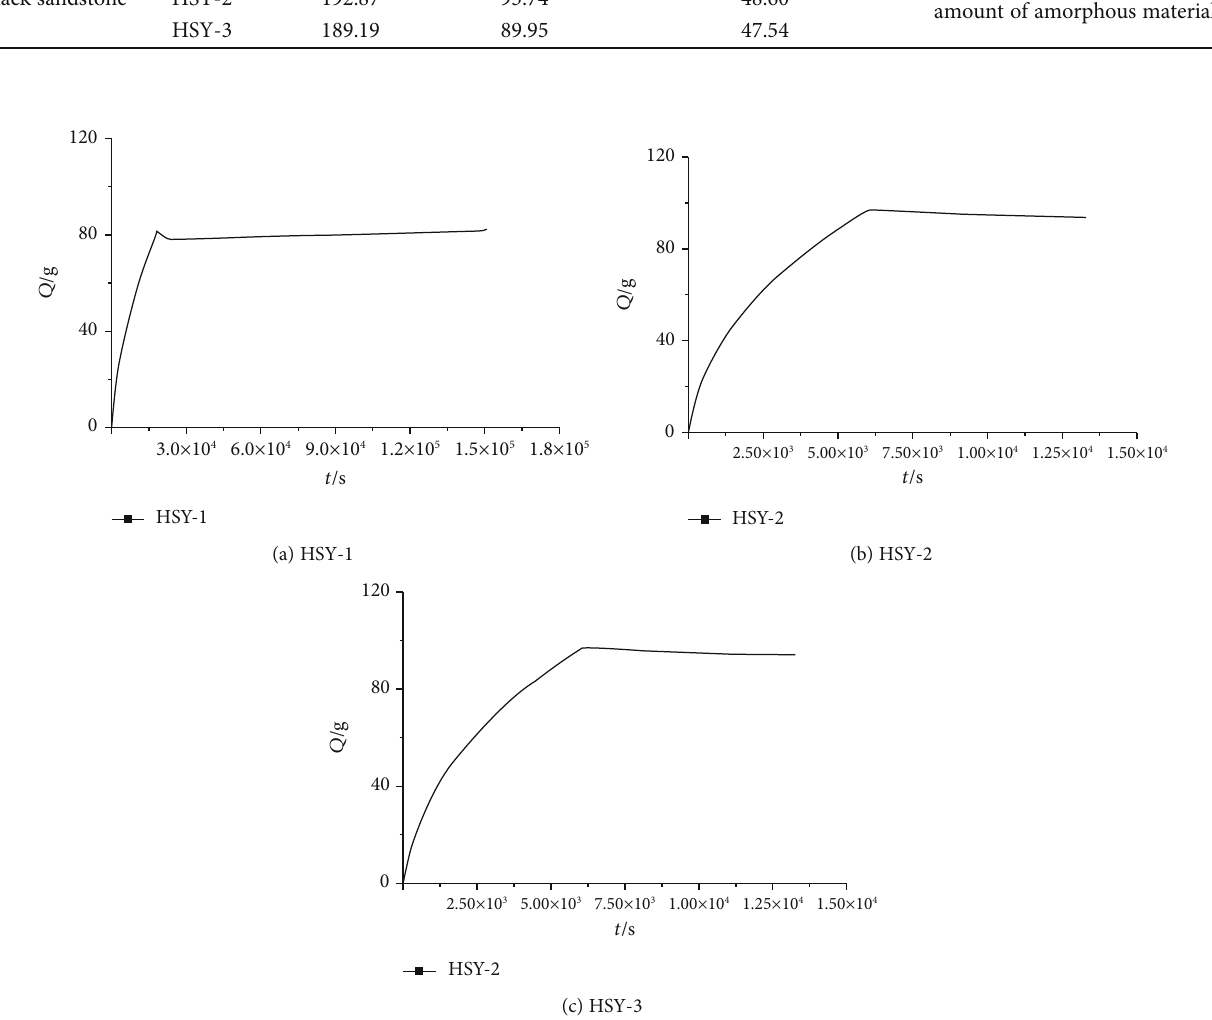
Figure 14: Black sandstone Q – t curve of water absorption